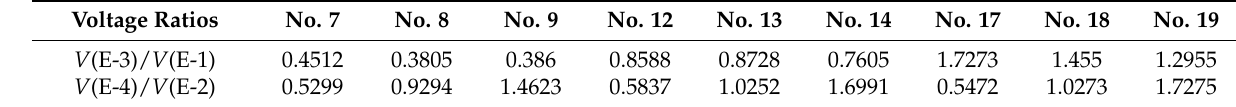
Table 3. Voltage ratios of No. 7 to No. 19 from E-2 to E-4 calculated using MATLAB.